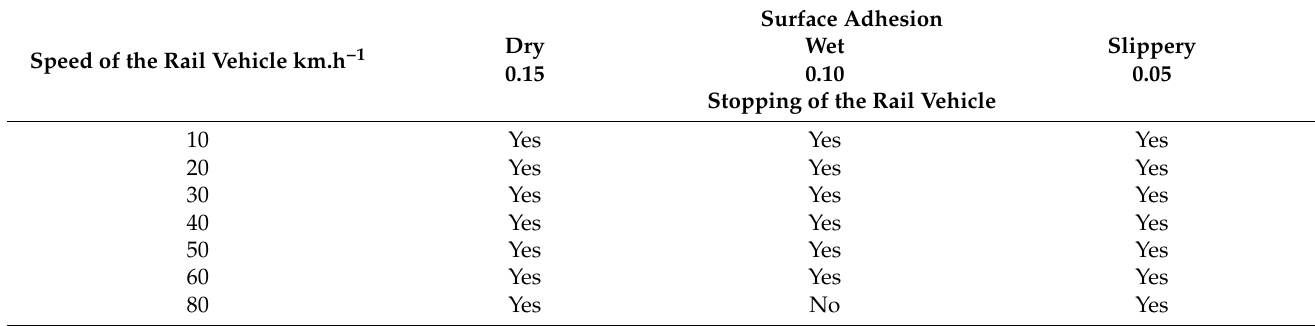
Table 7. Possibilities of avoiding collisions at crossing P5967 in the direction of Horn í Dvoˇrištˇe.